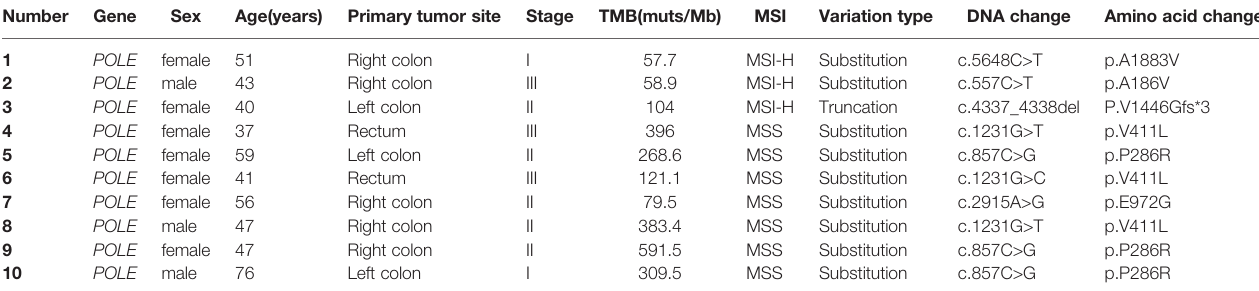
TABLE 4 | Clinical and molecular characteristics of MC with POLE